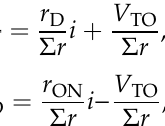
Figure 4. Half-bridge circuit ( a ) and basic waveforms ( b ) for square-wave operation simulated in Saber.